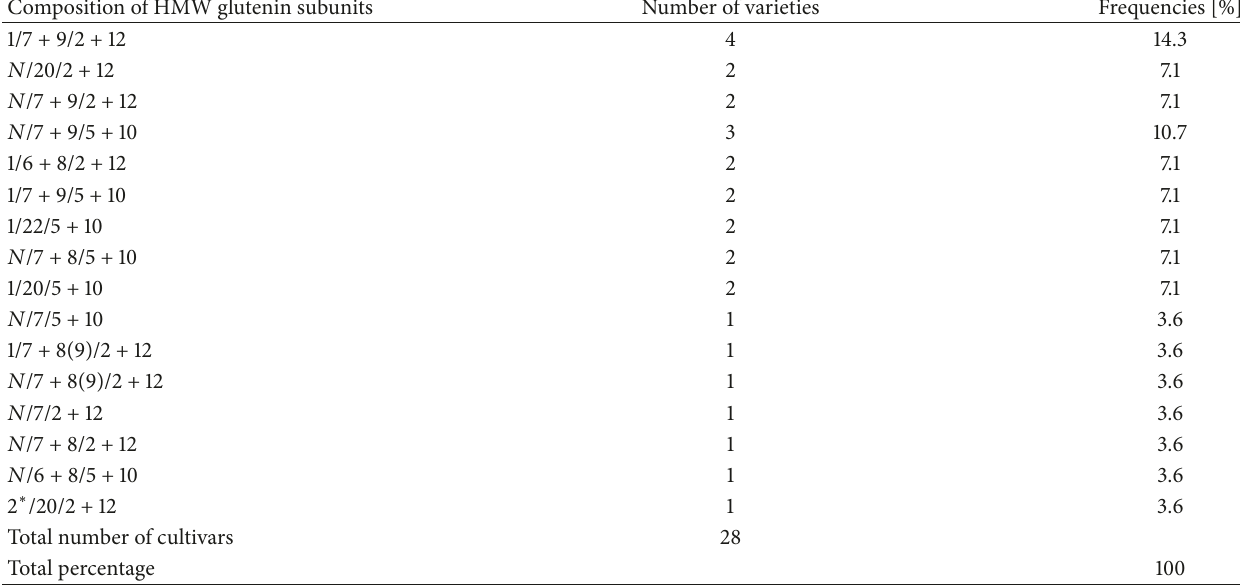
Table 3: The identified (SDS-PAGE) gluten subunits in the wheat varieties studied.